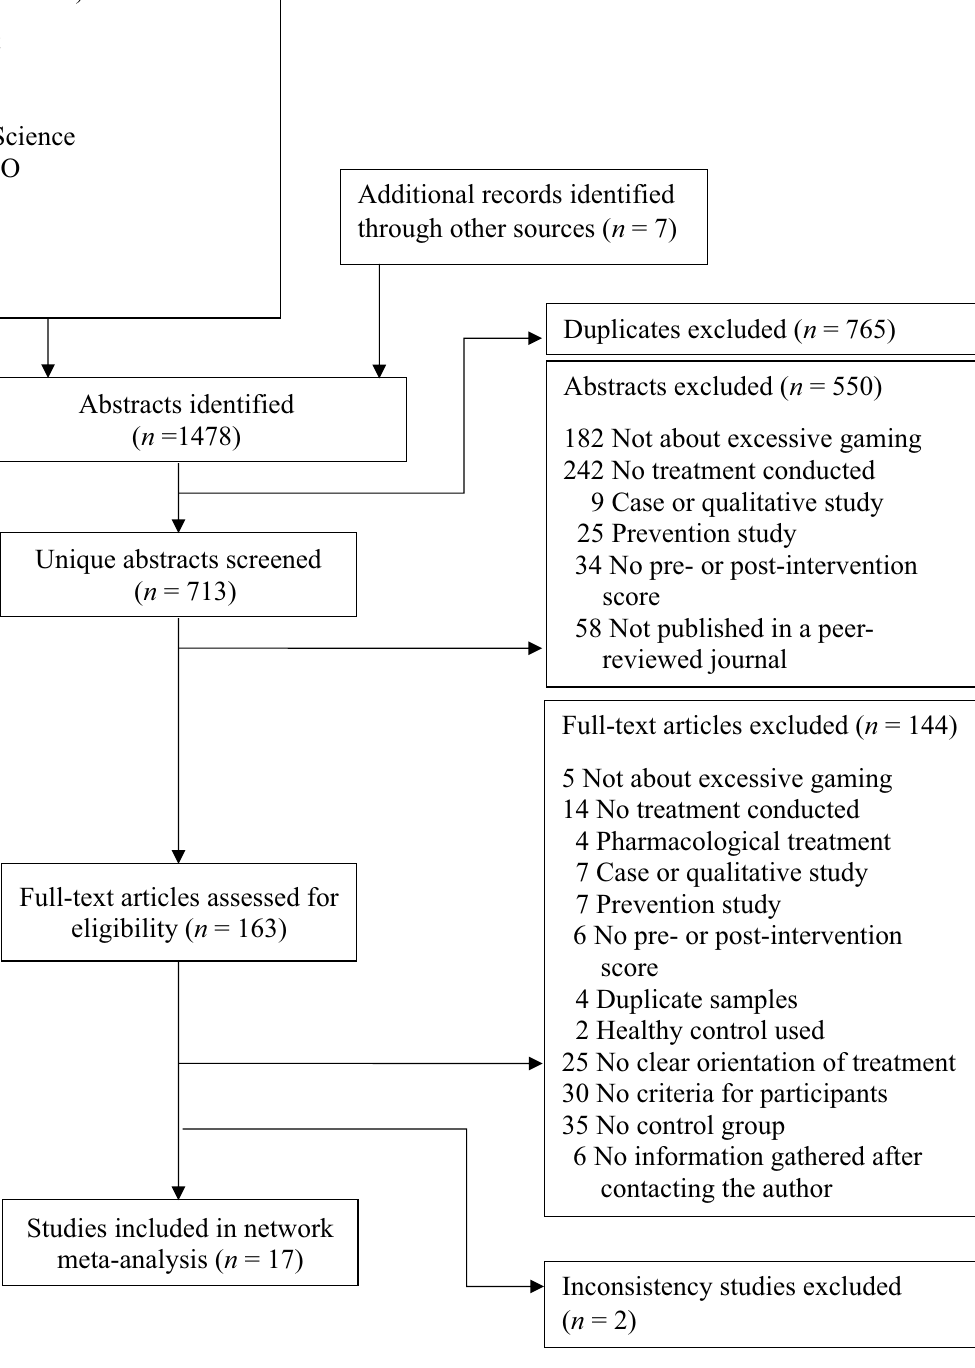
Pairwise meta‑analysis. The results of meta-analyses showed a large effect of all psychological treatments chological treatments were large when compared to the active control ( n = 5, g = 0.88, 95% CI [0.21, 1.56]) or inactive control ( n = 12, g = 1.70, 95% CI: [1.27, 2.12]). Substantial heterogeneity was evident in studies that were